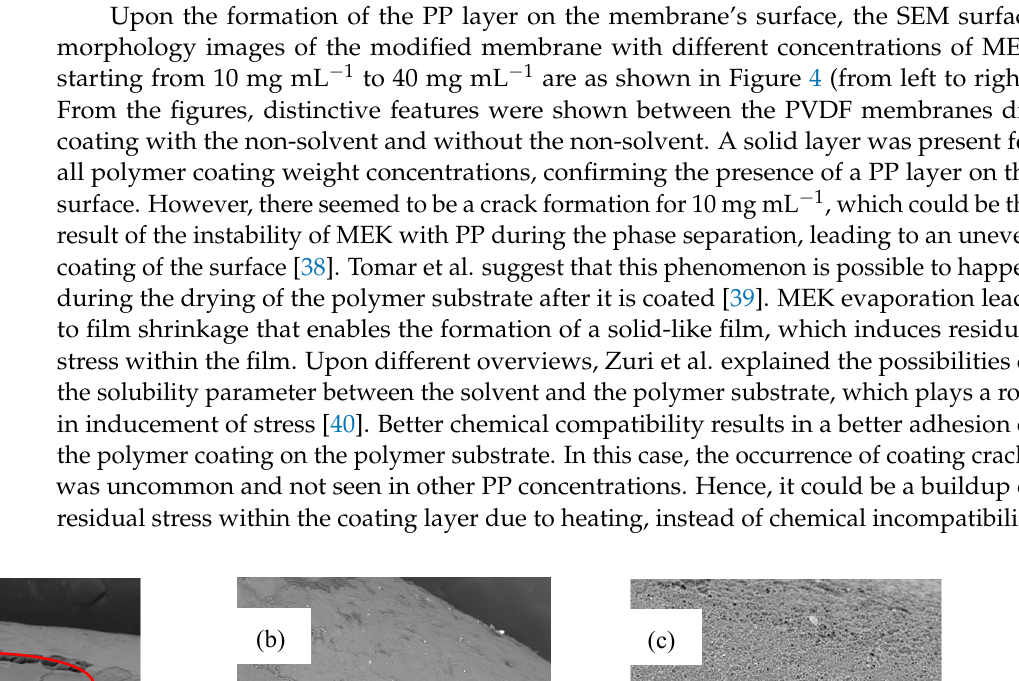
Figure 4. SEM surface morphology images for the modified membranes with the non-solvent at different concentrations: ( a ) 10 mg mL − 1 ; ( b ) 25 mg mL − 1 ; and ( c ) 40 mg mL − 1 . A magnification of 150× was used for each concentration. Figure 5. SEM cross-section images for the pristine membrane ( a ) and the modified membranes with MEK at concentrations of 10 mg mL − 1 ( b ), 25 mg mL − 1 ( c ), and 40 mg mL − 1 ( d ). A magnification of 300× was used for all concentrations.